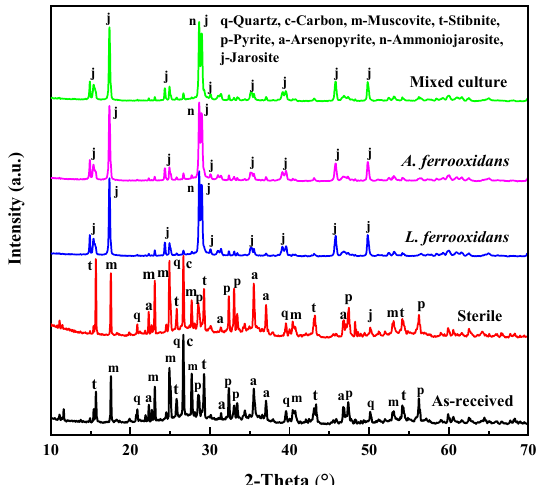
ff raction patterns for the as-received, bio-oxidized and sterile control Figure 2. XRD diffraction patterns for the as-received, bio-oxidized and sterile control DRGO. Figure 2. XRD di